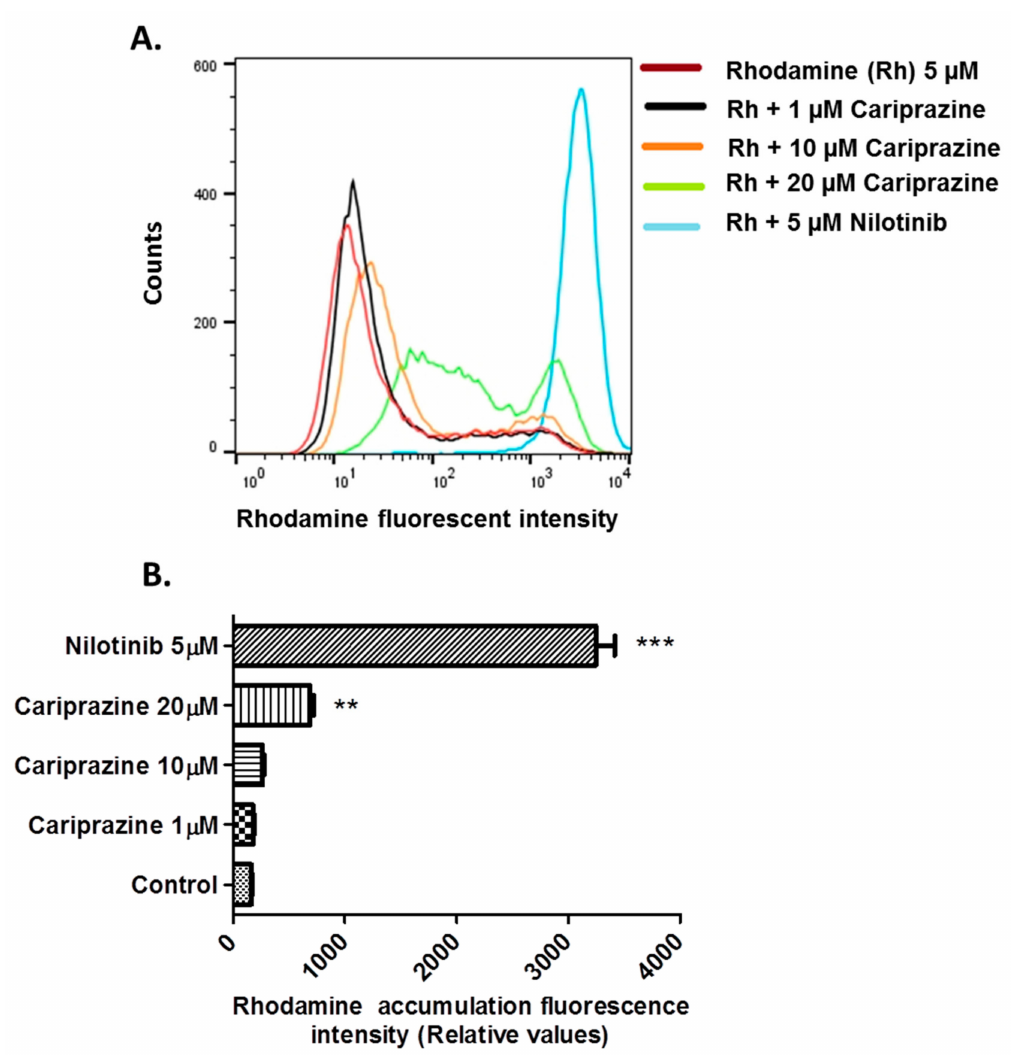
Figure 6. The effect of cariprazine, and nilotinib on the intracellular accumulation of rhodamine 123 in ABCG2 overexpressing S1M1-80 cells. ( A ) The accumulation of rhodamine 123 was increased in a dose-dependent manner in S1M1-80 cells incubated with cariprazine. Red filled, control; black, 1 µ M; orange, 10 µ M; green, 20 µ M; blue, nilotinib, 5 µ M. ( B ) Rhodamine 123 levels were expressed as the units of mean fluorescent intensity. The data shown as means ± SD of triplicate